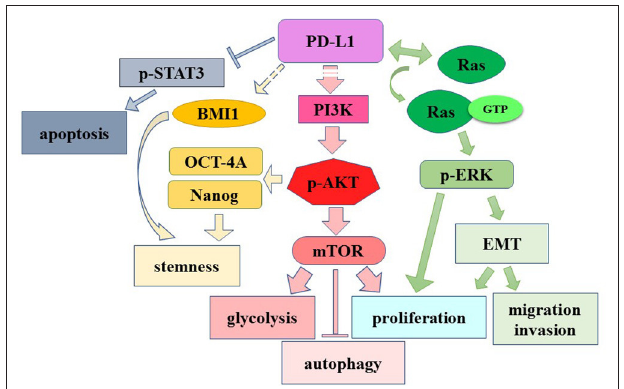
FIGURE 3 | The role of cell-intrinsic PD-L1 in modulating signaling pathway. Dashed lines: unknown mechanisms. → , induction or activation; → ,